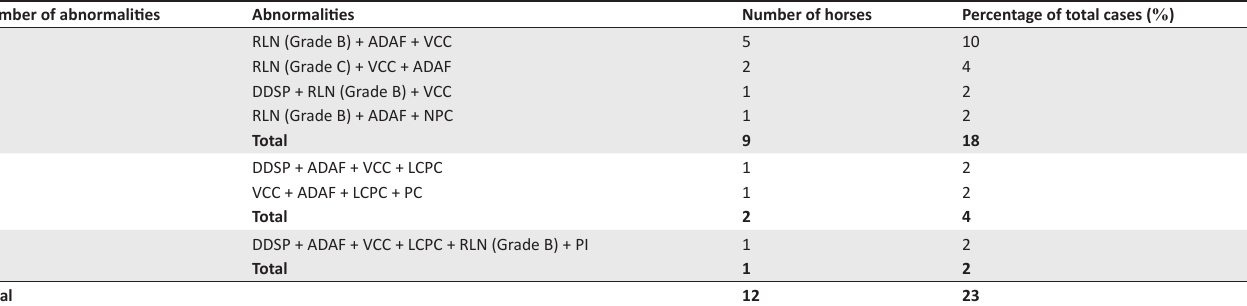
doi:10.4102/jsava.v85i1.1140http://www.jsava.co.za